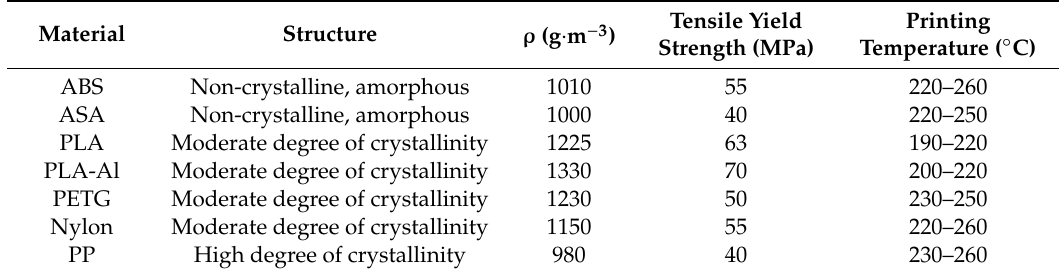
Table 1. Structural, thermal, and mechanical properties of test materials